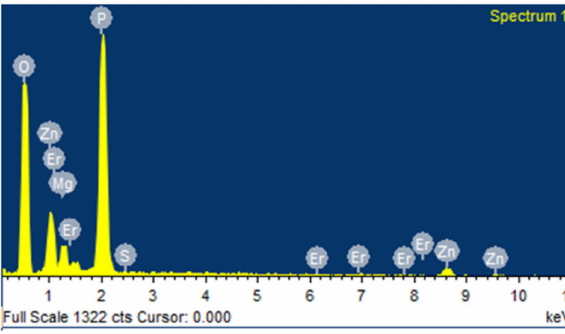
Figure 1. EDX Spectrum of PMZ0.5Er glass